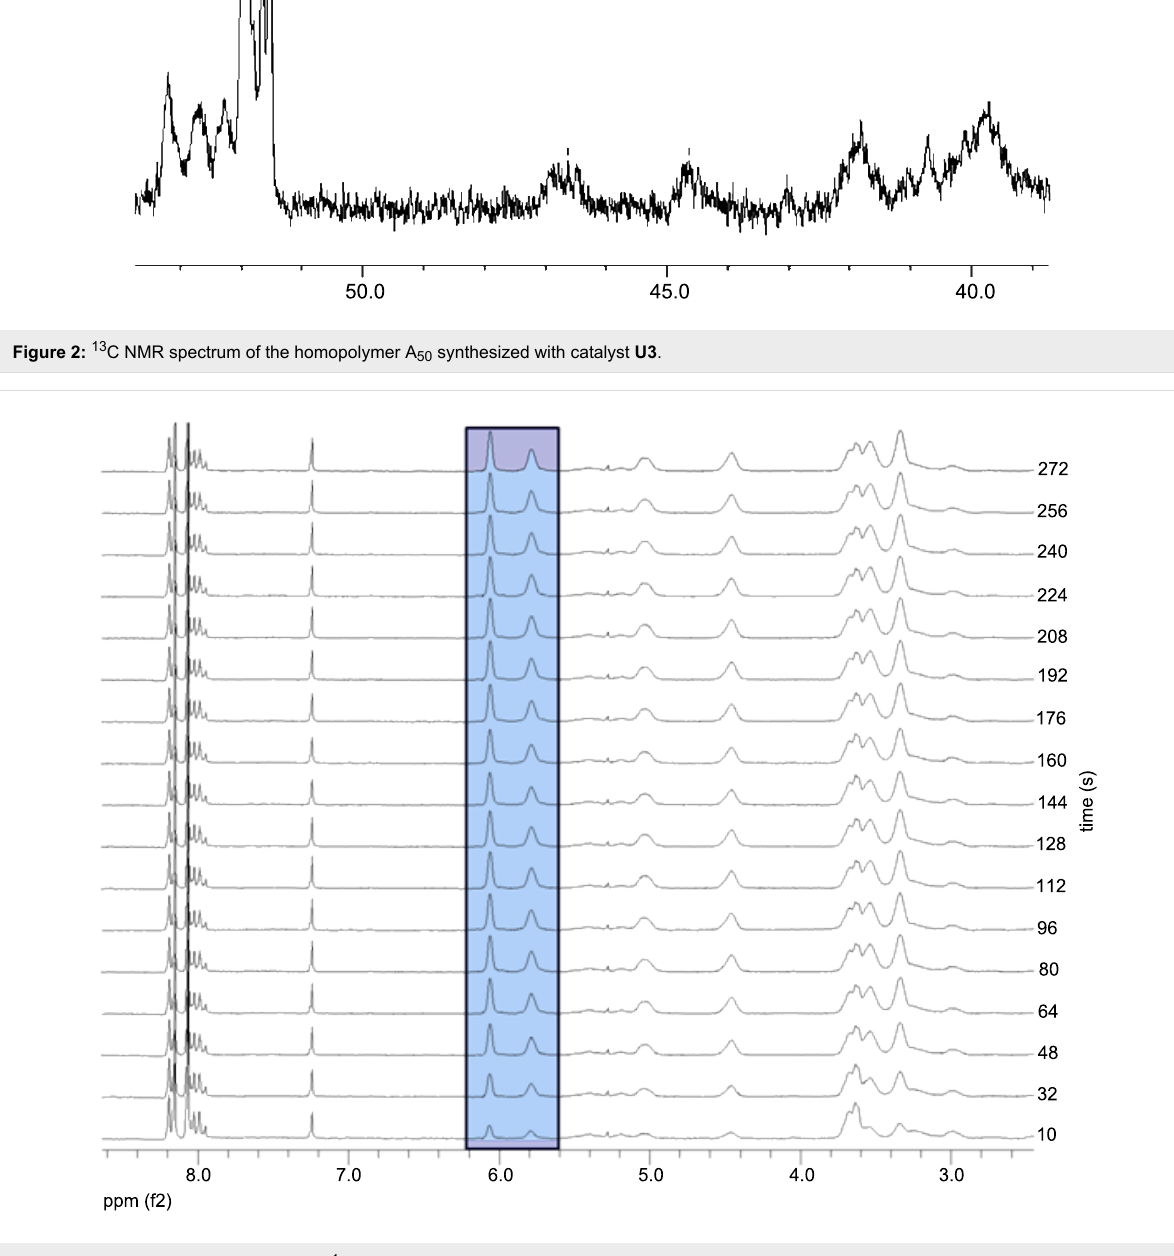
Figure 3: Kinetic progress monitored via 1 H NMR spectroscopy of the polymerization of monomer A 7 with catalyst U1 ; [ 7 ]/[ U1 ] =